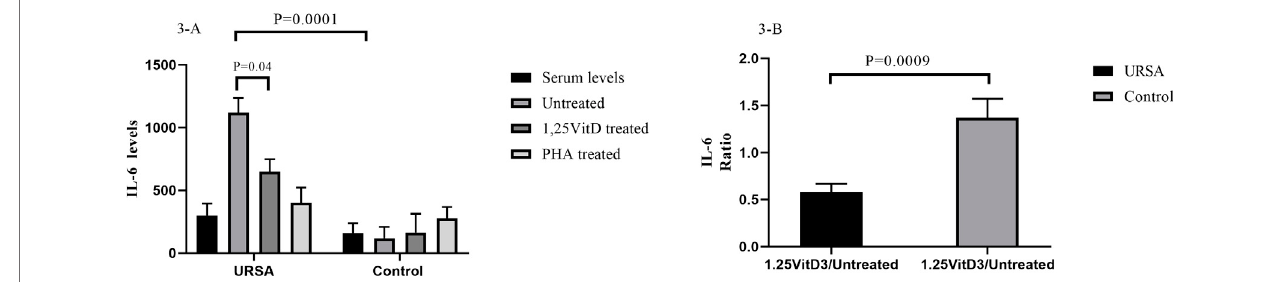
FIGURE 3 | IL-6 levels in serum and cell culture supernatants in women with URSA and the control group (A) . IL-6 levels in the cell culture supernatant increased signi fi cantlyinthecasegroupincomparisontothecontrolgroup.Incellculturesupernatants,1,25VitD3treatmentdecreasedIL-6levelscomparedtountreatedPBMCs only in the case group. (B) . IL-6 levels in the presence of 1,25VitD3 to the baseline decreased in women with URSA relative to the control